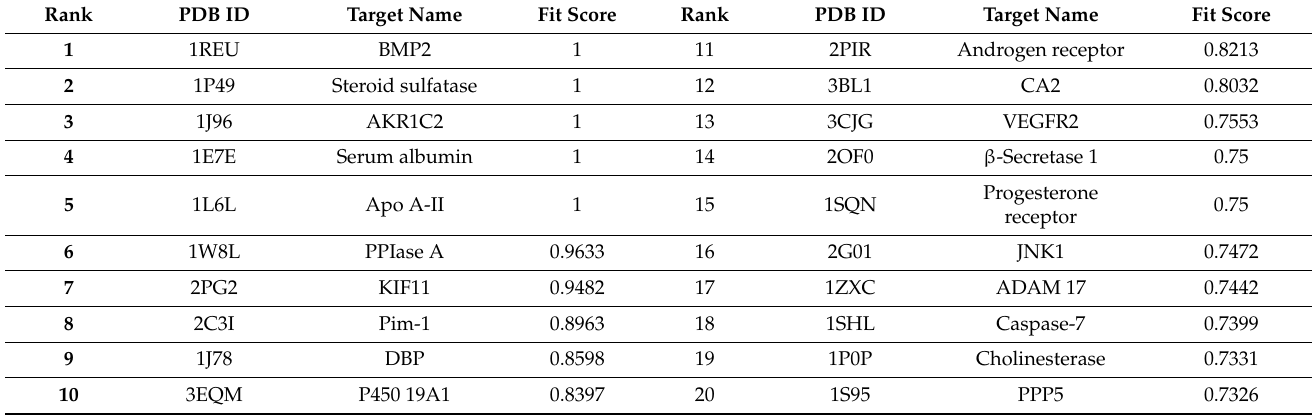
Table 5. Potential protein targets of (+)-cedrol identified by PharmMapper.